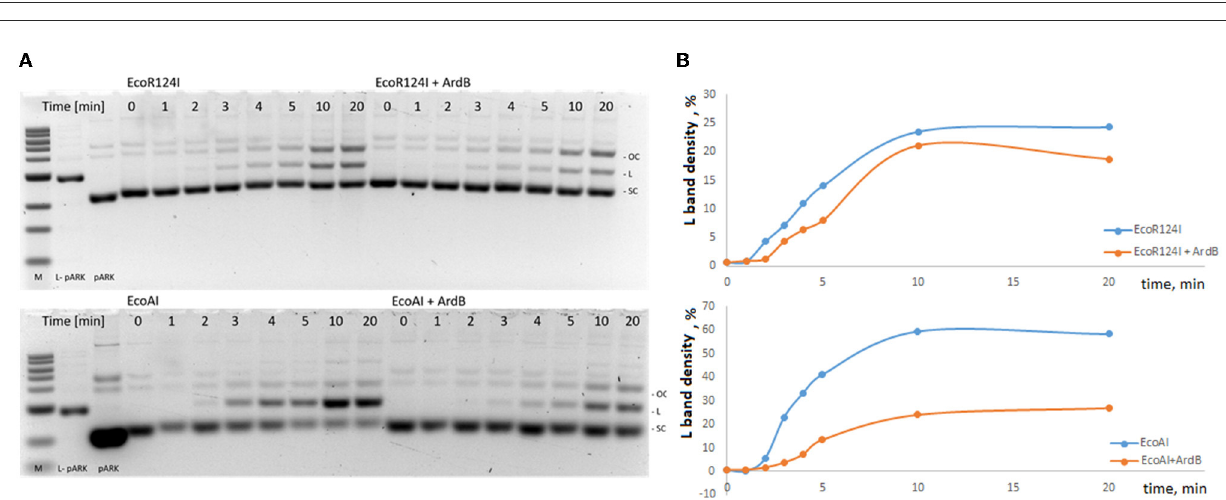
FIGURE2 Influence of ArdB presence on the endonuclease activity of IB and IC RMI-systems EcoR124I and EcoAI in vitro. (A) 1% agarose gel electrophoresis: lane 1- − 1kb ladder, lane 2—linear plasmid pARK, lane 3—circular plasmid pARK, lanes 4–11—incubation time (min) of the mix containing 10nM pARK, 10nM EcoR124I, or EcoAI endonuclease; lanes 12–19—incubation time (min) of the mix containing 10nM pARK, 10nM EcoR124I, or EcoAI endonuclease with 300nM ArdB). (B) The percentage of linear plasmid at total plasmid band density (L band density, Lbd) measured with TotalLab Quant software. A typical experiment is presented. The ratios Lbd(EcoR124I)/Lbd(EcoR124I + ArdB) and Lbd(EcoAI24I)/Lbd(EcoAI24I + ArdB) were measured for three independent experiments at 5min and equaled 1,35 ± 0,1 and 3,38 ± 0,3,